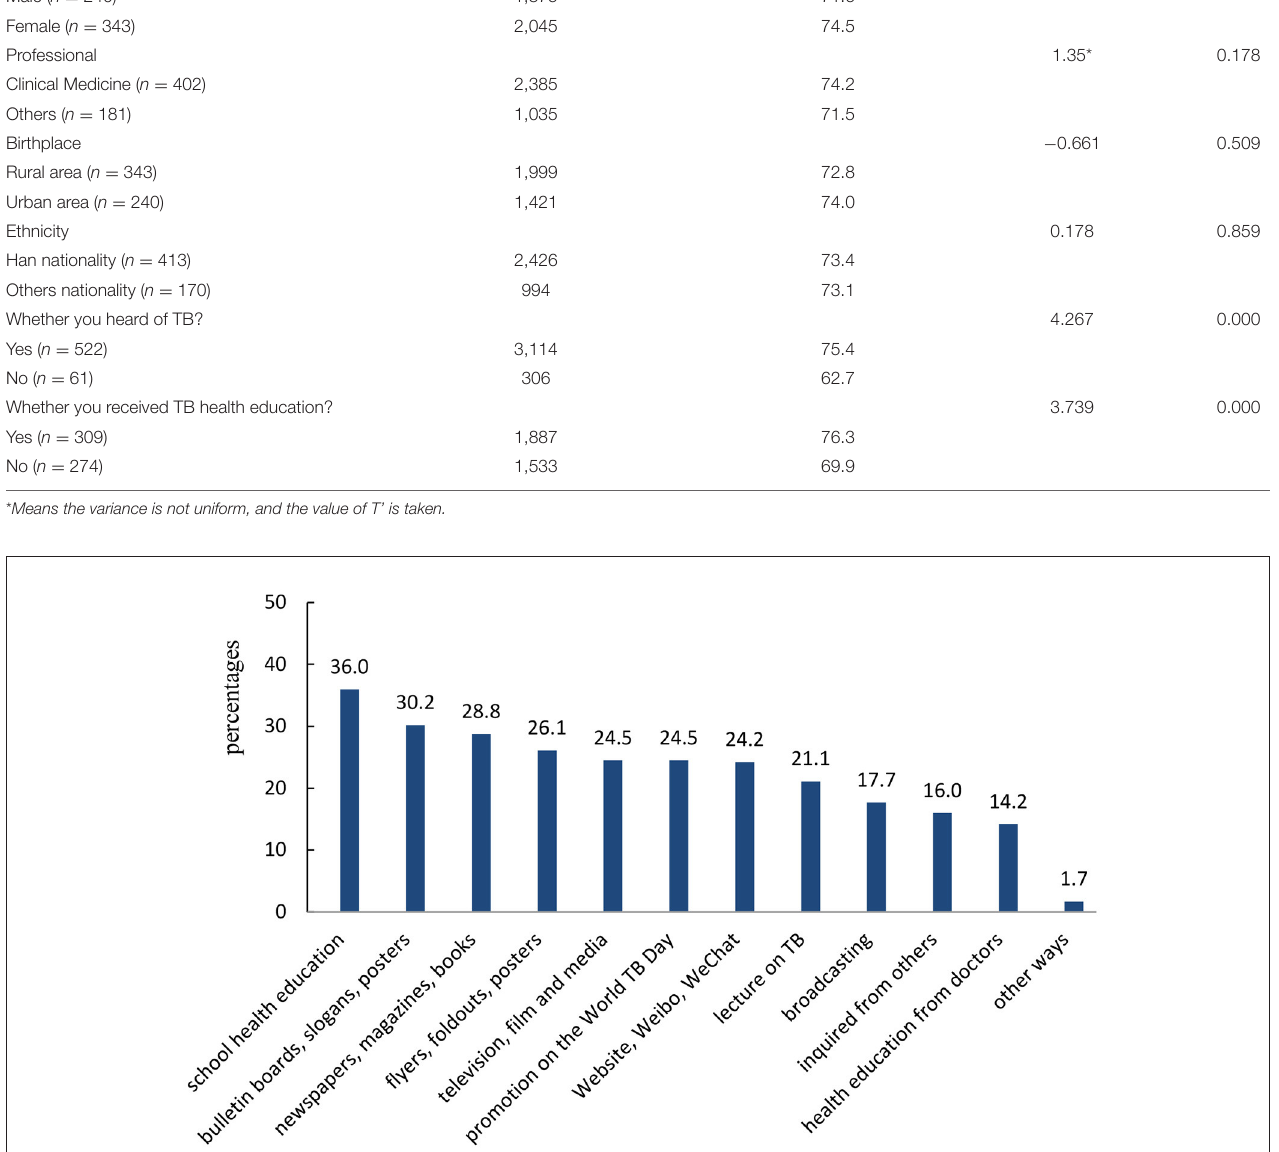
Campaign,” and “Publicity Columns, Slogans, and Posters”, respectively. Regarding the presentation of online health education, 66.4 and 64% of freshmen preferred presentations that comprised of “text + video” and “text + picture,”